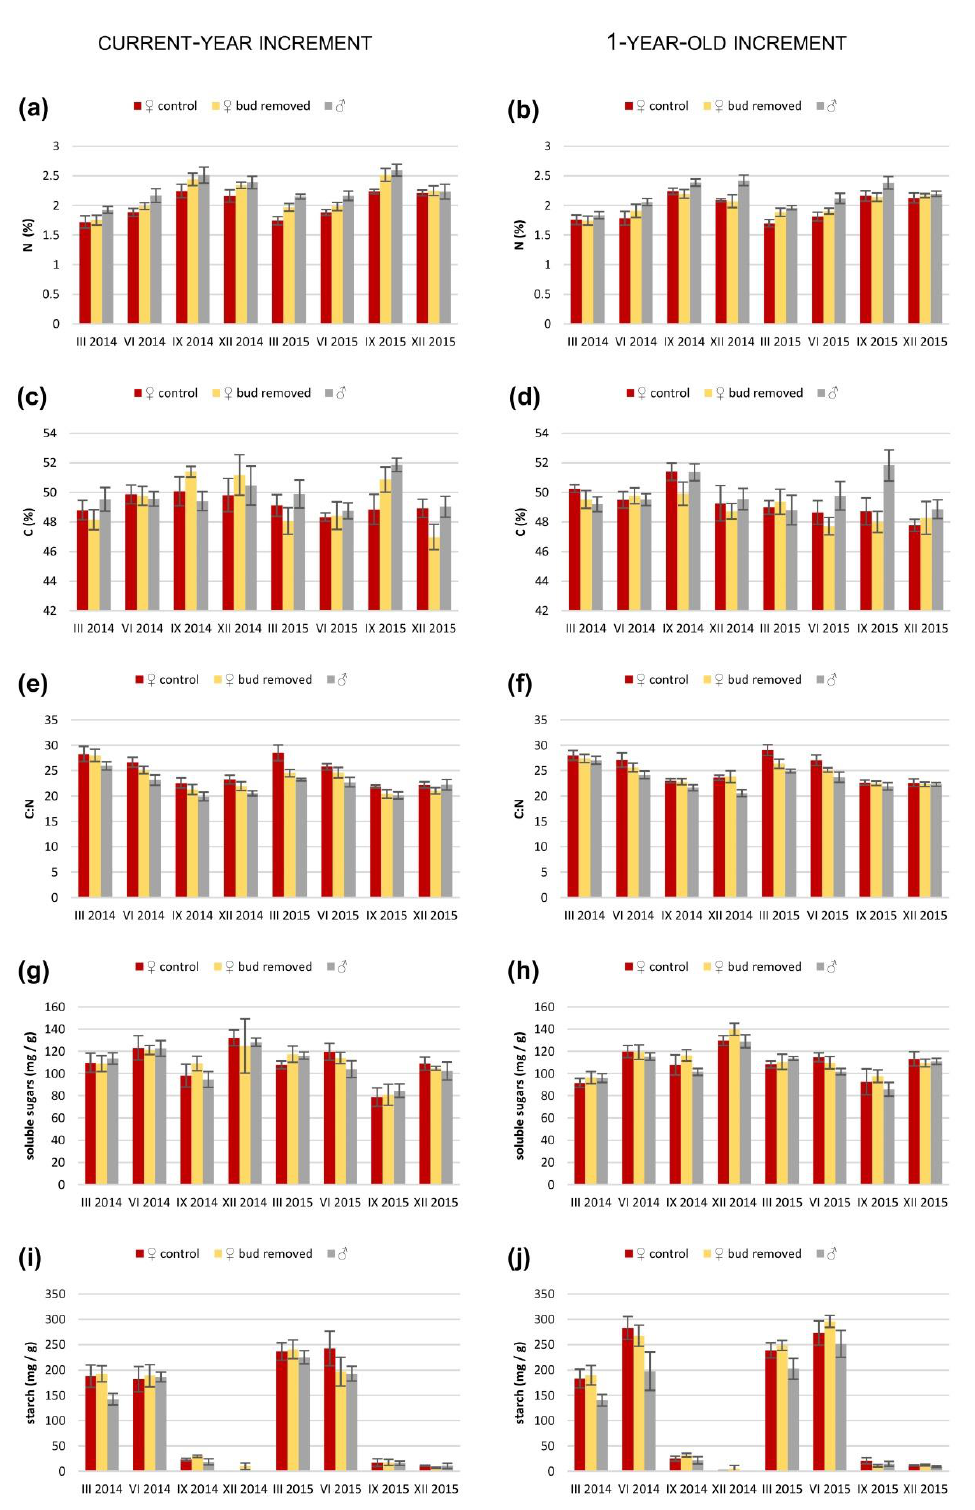
Figure 1. Mean values (±standard error) of concentration of ( a , b ) nitrogen; ( c , d ) carbon; ( e , f ) C:N ratio, and concentration of ( g , h ) soluble sugars and ( i , j ) starch in ( a , c , e , g , i ) current-year increments and ( b , d , f , h , j ) 1-year-old increments in control and bud-removed Taxus baccata female shoots and in male shoots measured in different seasons for two years.